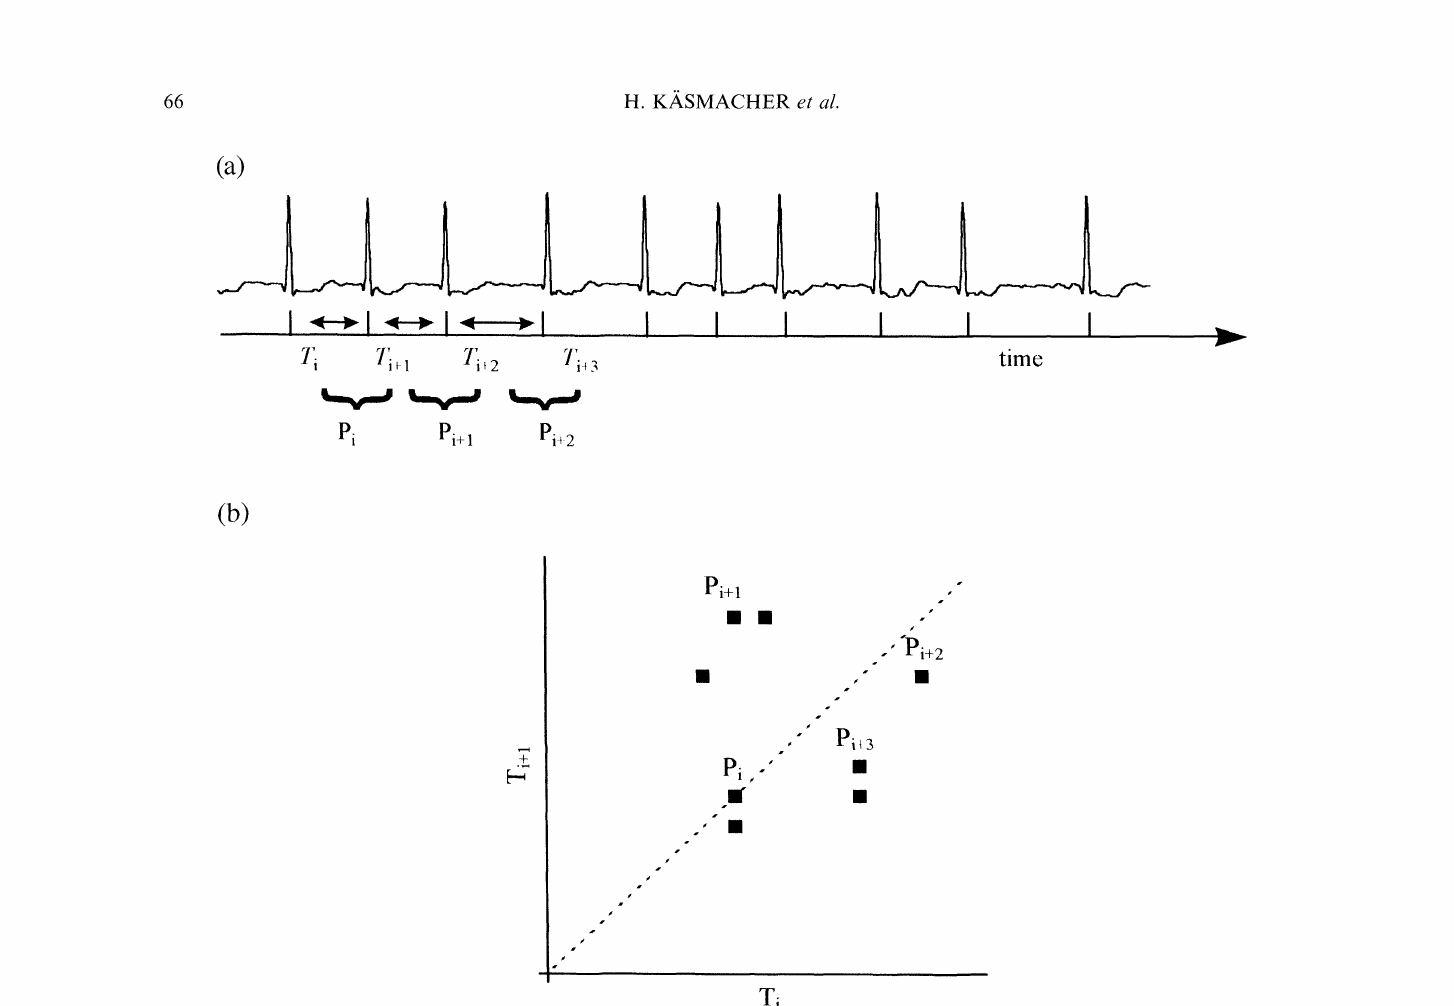
Construction of the Poincar&plots: (a) Interval lengths are measured in an ECG recording (T,., Ti+ 1, etc.). Adjacent . , etc.) in a Cartesian co-ordinate system (b) the axis of which are intervals form a couple which define a particular point (P;, Pi+ Ti and T+ respectively. Likewise the whole registration is depicted. The dotted line is the line of identity, i.e. T; T+ Poincar&plot which is applicable for discrete data as opposed to the conventional phase-space-plot where the concerned parameter is plotted against its first derivative which requires continuous data (Denton et al., 1990). However, these maps are closely related because the x-axes are identical (parameter amplitude), while the y-axes are mathe- matically related (the y-axis of the Poincar&plot is x + Ax/At, and the y-axis of the phase-plane- plot is